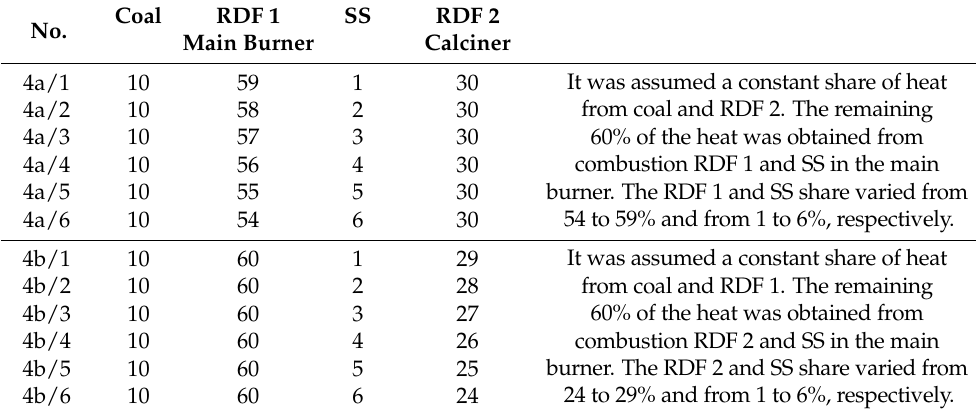
burner. The RDF 2 and SS share varied from 24 to 29% and from 1 to 6%, Table 4. The physicochemical parameters of the tested fuels. Parameter Coal RDF 1 RDF 2 Proximate analysis (wt.%)